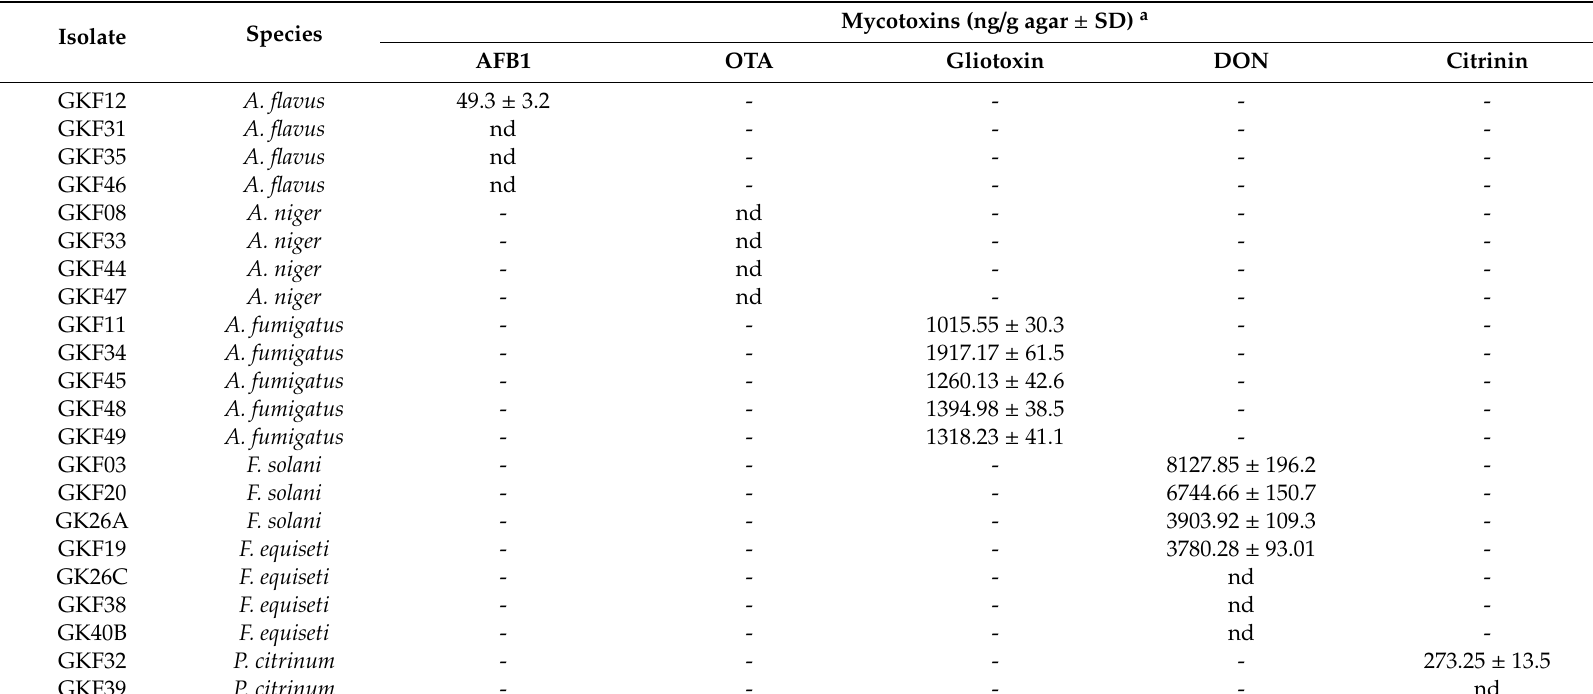
Table 1. Mycotoxigenic capacity of fungi isolated from fresh